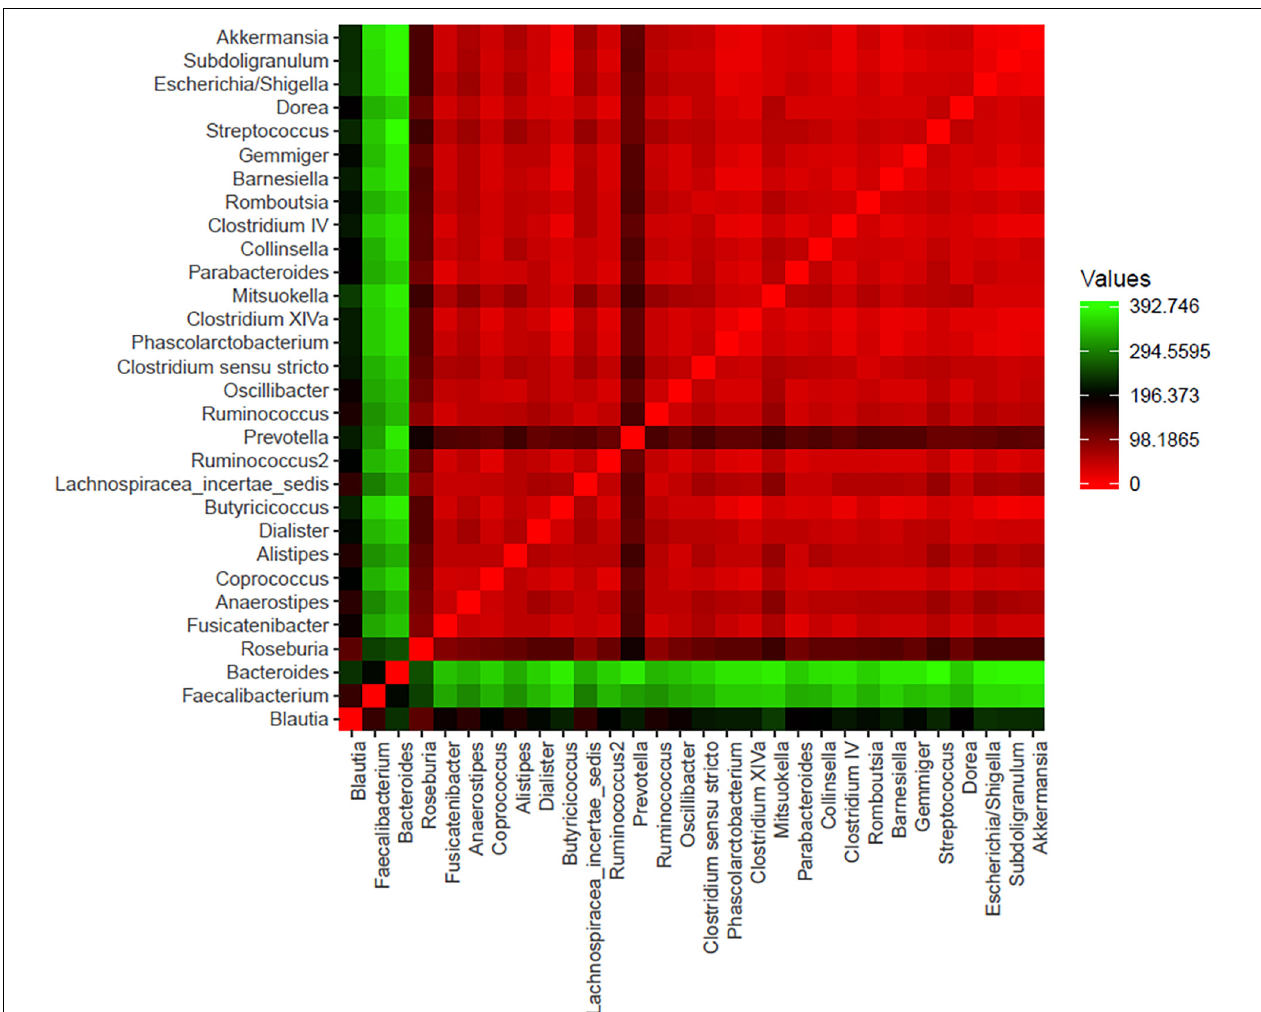
FIGURE 2 | The set of 30 bacterial genera identified as one of the 10 most abundant bacterial genera within at least one sample within both groups of samples. Core microbiome is typical for seniors. The minimum abundance must reach at least 1% of all bacteria and in at least one sample of both